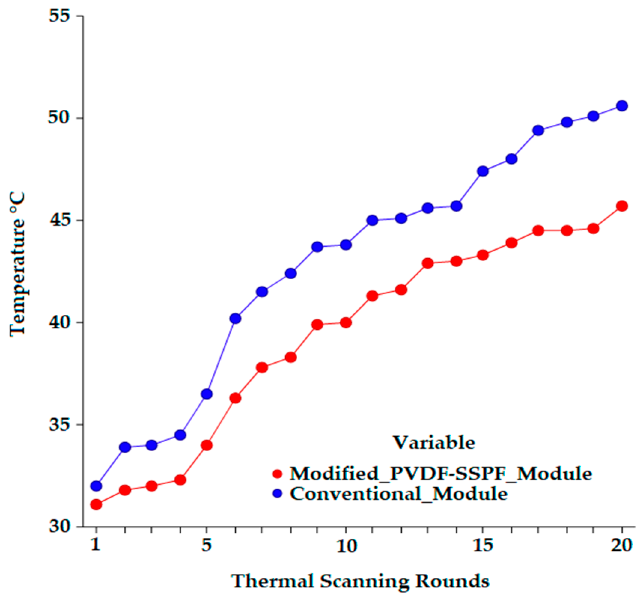
Figure 6. Proportional performance of the thermal behavior of backsheets attached to the tested modules.